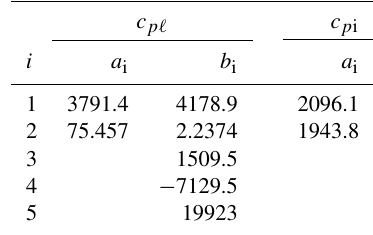
Table 1. Coefficients a i and b i in Eqs. (6)–(7) for the specific heat of liquid water and of ice ( c p(cid:96) and c p i in Jkg − 1 K − 1